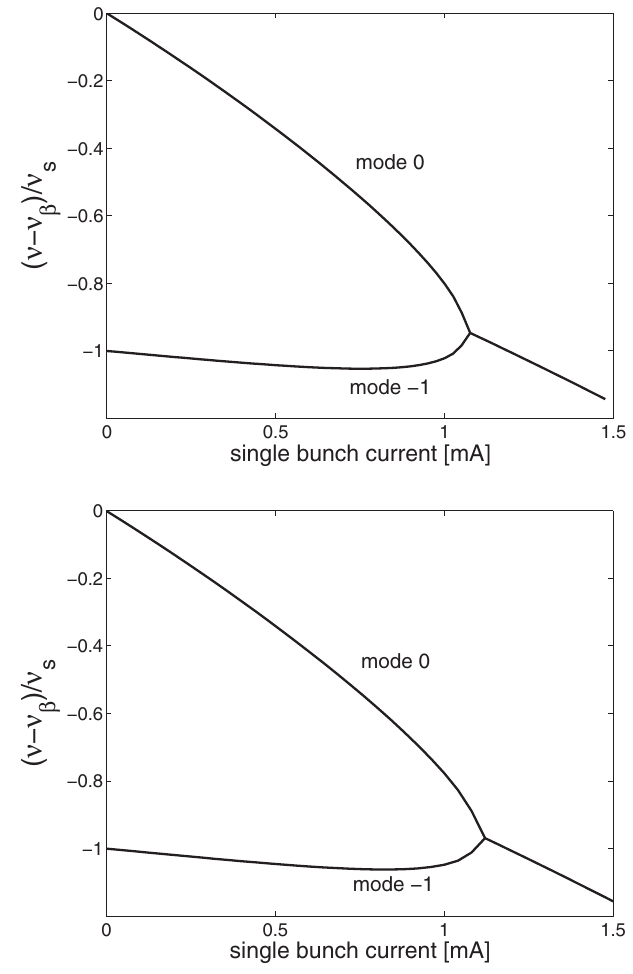
FIG. 15. The vertical (above) and horizontal (below) mode detuning obtained from the geometrical and resistive wall im- pedance using MOSES . Normalization of the betatron tune shifts on the current dependent incoherent synchrotron tune (cid:11) TMC instability occurs at a slightly higher current above the mode merging when the growth rate of the instable mode is larger than the radiation